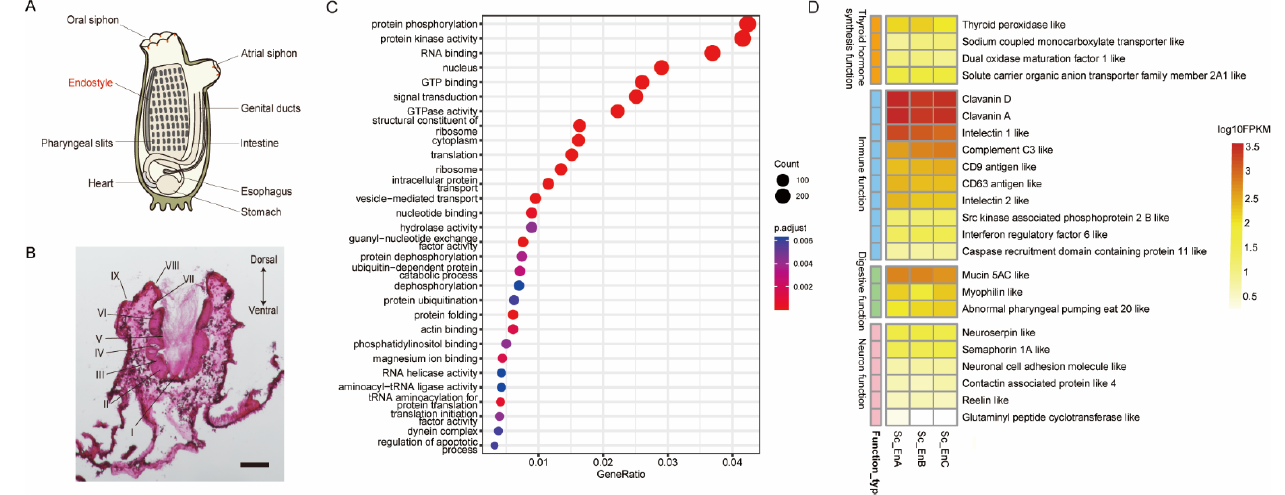
Figure 1. Morphology and transcriptional profile of ascidian endostyle. ( A ) Location of endostyle in adult ascidian; ( B ) HE staining on cross-sections of endostyle in S. clava . The relative positions of nine regions were labeled. Bar: 100 μ m; ( C ) top expressed gene terms of endostyle by GO enrichment analysis. ( D ) Heatmap of top functional gene expression level for four main functional categories of the endostyle.